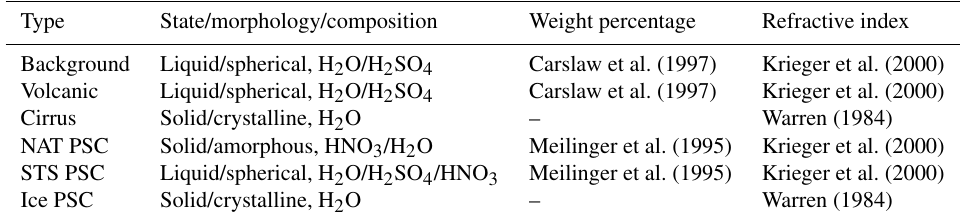
Table 2. The types of particles that are to be expected in the GOMOS data, with characteristics. The methods used to estimate composition (from temperature) and refractive index are also indicated.